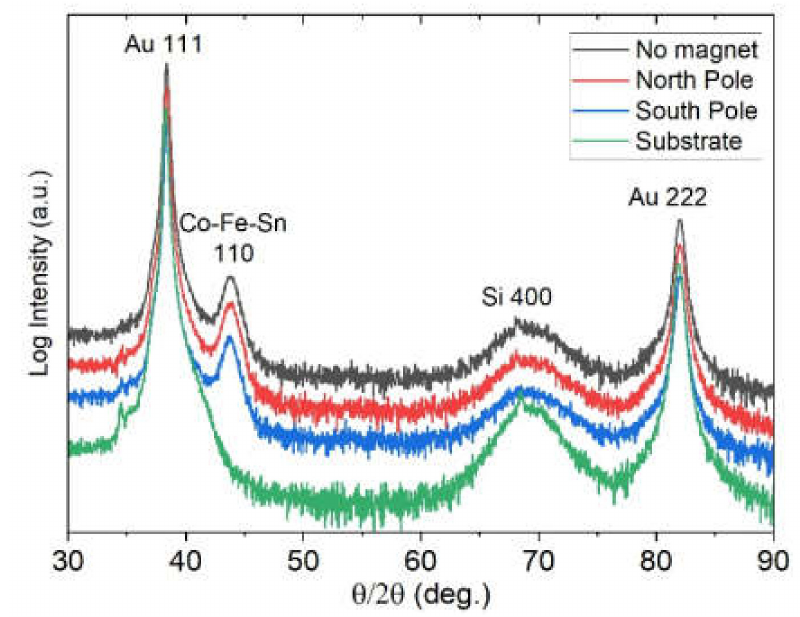
Figure 4. XRD analysis of the samples obtained in absence and presence of the magnet under the electrode. The substrate diffractogram of the substrate is reported for